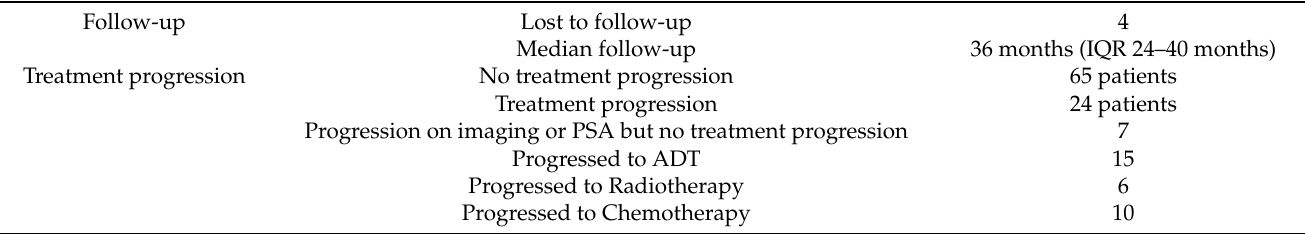
Table 5. Follow-up and treatment